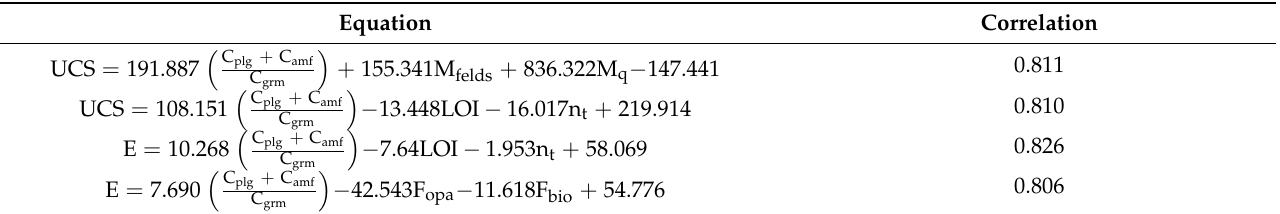
Table 12. Some significant multiple regression equations [57] (C plg . is plagioclase content in %, C amf. is amphibole content in %, C GrM. is groundmass content for all types of composition in %, M felds. is the mass fraction of total feldspar minerals in %, M q. is the mass fraction of quartz in %. n t is total porosity, F opa . is Feret’s diameter of opaque minerals in mm, F bio. is Feret’s diameter of biotite in mm, LOI is loss-on-ignition values in %, E is Young’s modulus (Gpa), and UCS is the uniaxial compressive strength of rock in